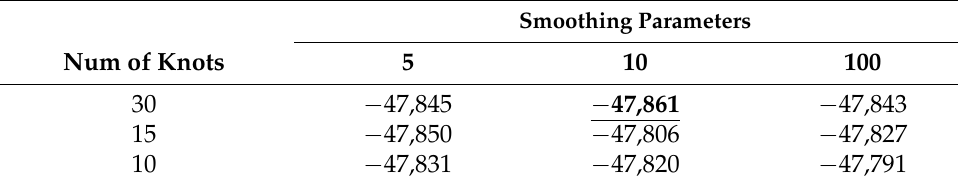
Table 21. DIC for Gamma distribution (4 January 2016, JAL, Tokyo, Japan).